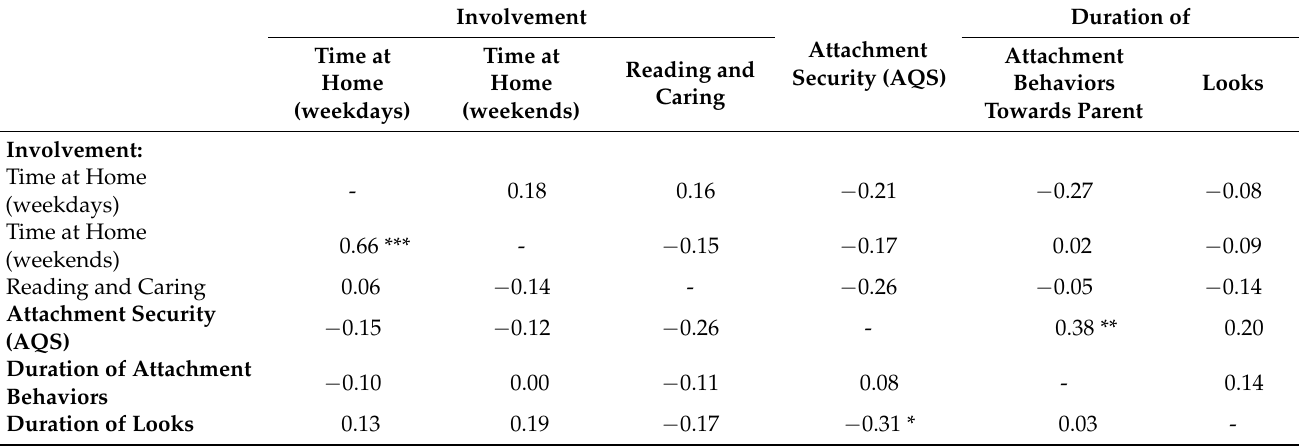
Table 1. Correlations of all variables (correlations for mothers below diagonal, correlations for fathers above diagonal).